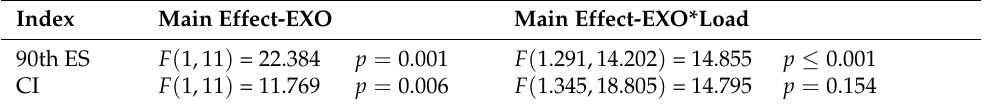
Table 1. Summary of statistical analysis on exoskeleton effect for the 0 ◦ trunk